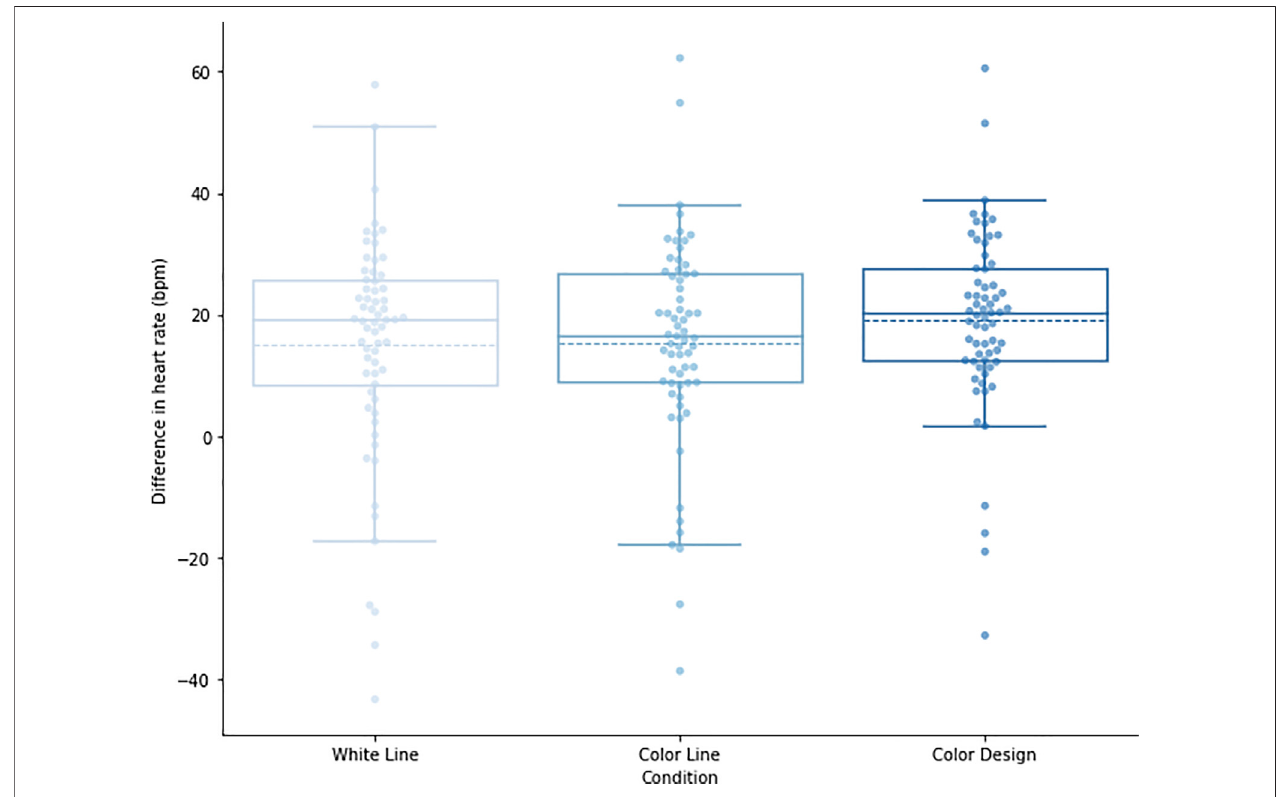
FIGURE6| BarchartsillustratingtheimpactofEnvironment(Concrete vs .Vegetation)onthephysiologicalchangesinheartrateduringspontaneouswalkinginthe three urban virtual environments.